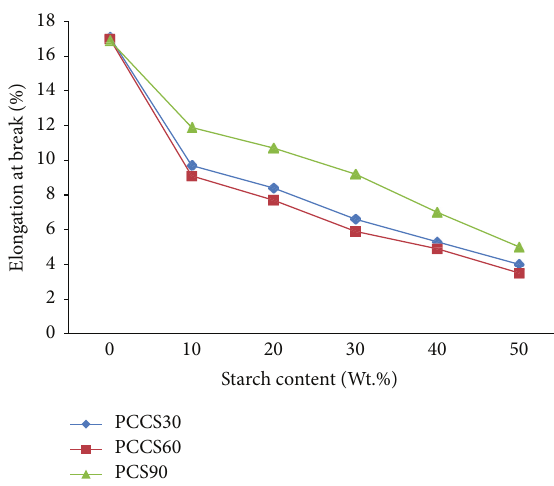
Figure 2: Tensile strength of PP/PCCS blends after the soil burial test.